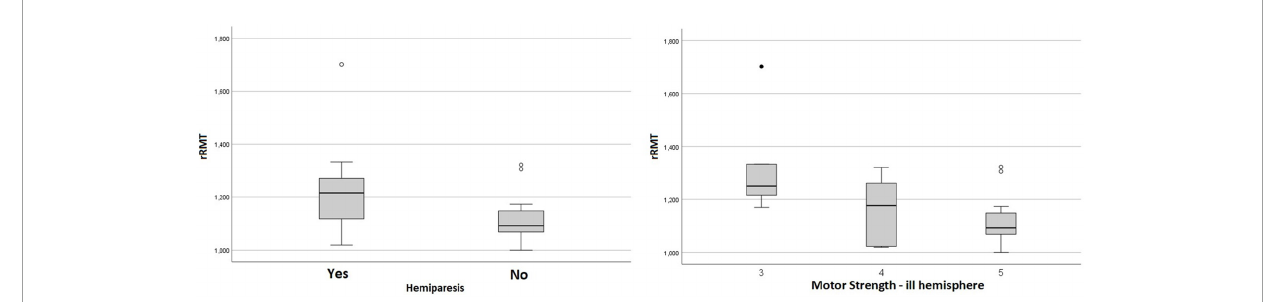
FIGURE3 Box plot graph of rRMT and hemiparesis and motor scores.